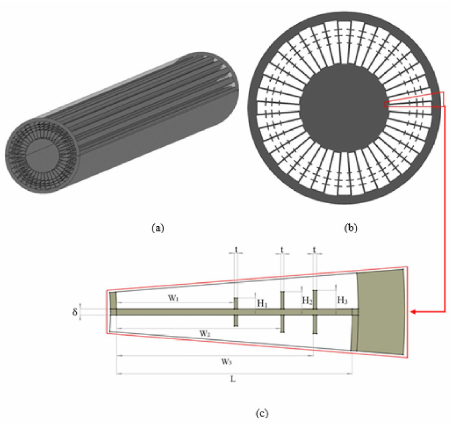
Figure 6. The physical model of design D PTHE-ZR. ( a ) three-dimensional view, ( b ) cross-sectional view and ( c ) computational